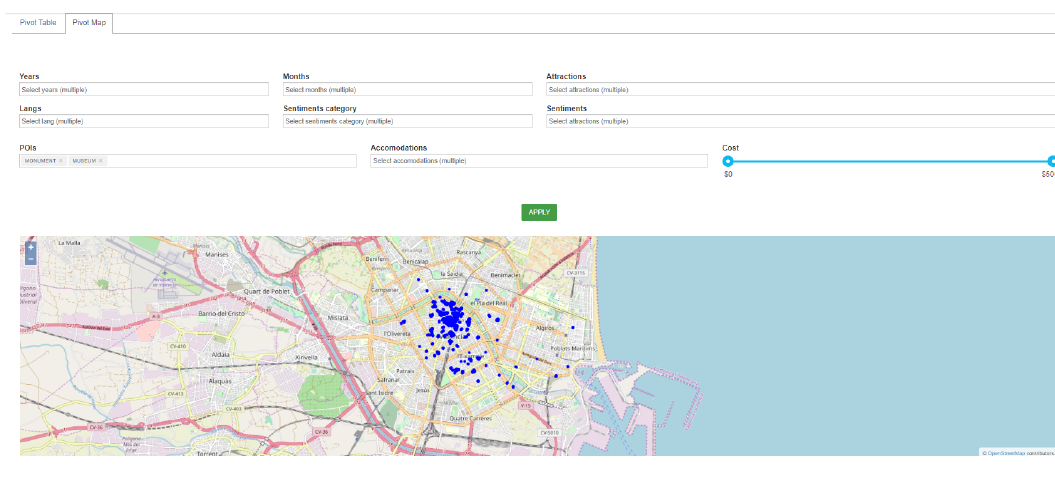
Figure 12. Tweets from Airbnb accommodations.